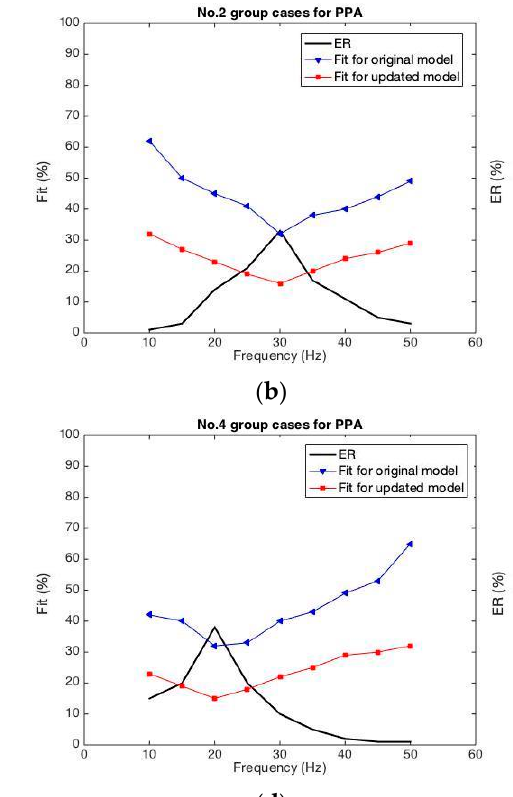
22 of 27 Figure 15. Comparison of experimental and simulation results in MFC. ( a ) Voltage vs. strain; ( b ) Power vs. strain. 5.2. Error Analysis “Fit” (from Equation (35)) is the error between the simulation and experiment results, which represents the model’s accuracy for a certain case (under a certain frequency, re- sistance, and mass weight). We found that the Fit values varied according to different cases. In order to test the effectiveness of the proposed model, an error analysis should be carried out. Four groups of cases in PPA, as previously mentioned in Section 2, were clas- sified according to four weight levels at the tip (0 g, 12.5 g, 18.75 g, and 25 g). Each group consisted of cases with different excitation frequencies, while resistances were set as the optimal resistance. Figure 16 shows the “Fit” values vs. excitation frequency for the four groups. As dis- played in Figure 16a, we found the “Fit” value for the original model is lowest at 34% when the excitation frequency approaches the resonant frequency (120 Hz). When the ex- citation frequency is changed to a value that is farther away from the resonant frequency,